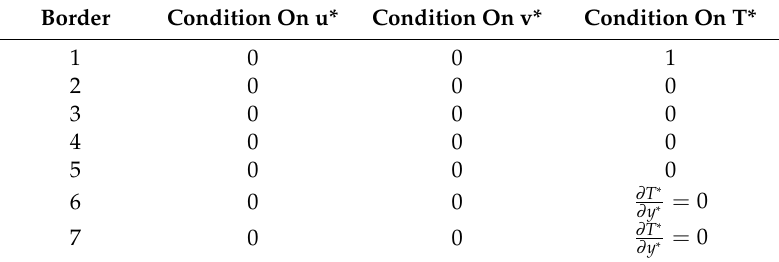
Table 1. The boundary conditions in dimensionless form. Border Condition On u* Condition On v* Condition On T* 1 0 0 1 2 0 0 0 3 0 0 0 4 0